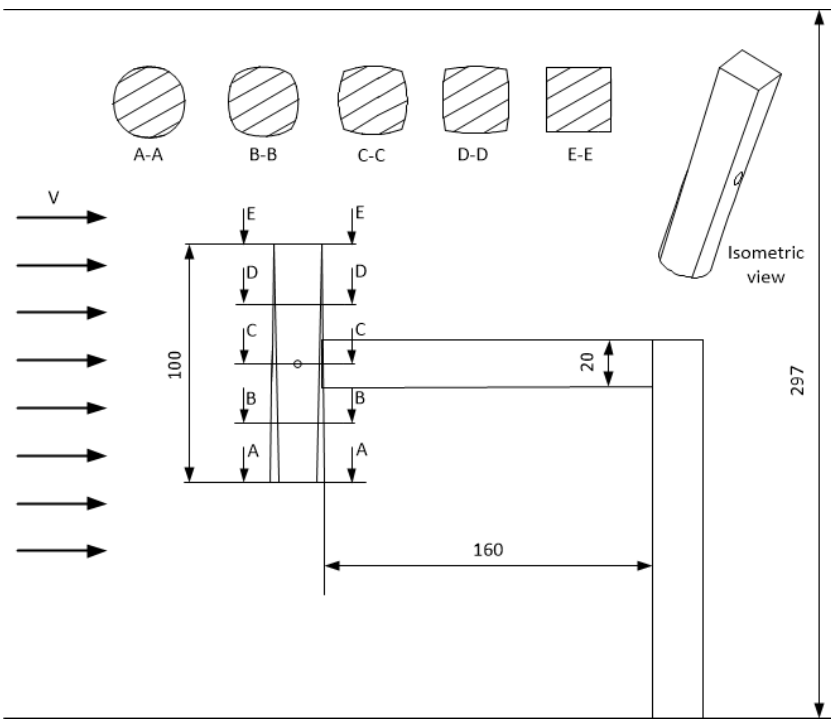
Figure 3. Bluff body geometry and the selected cross-sections.